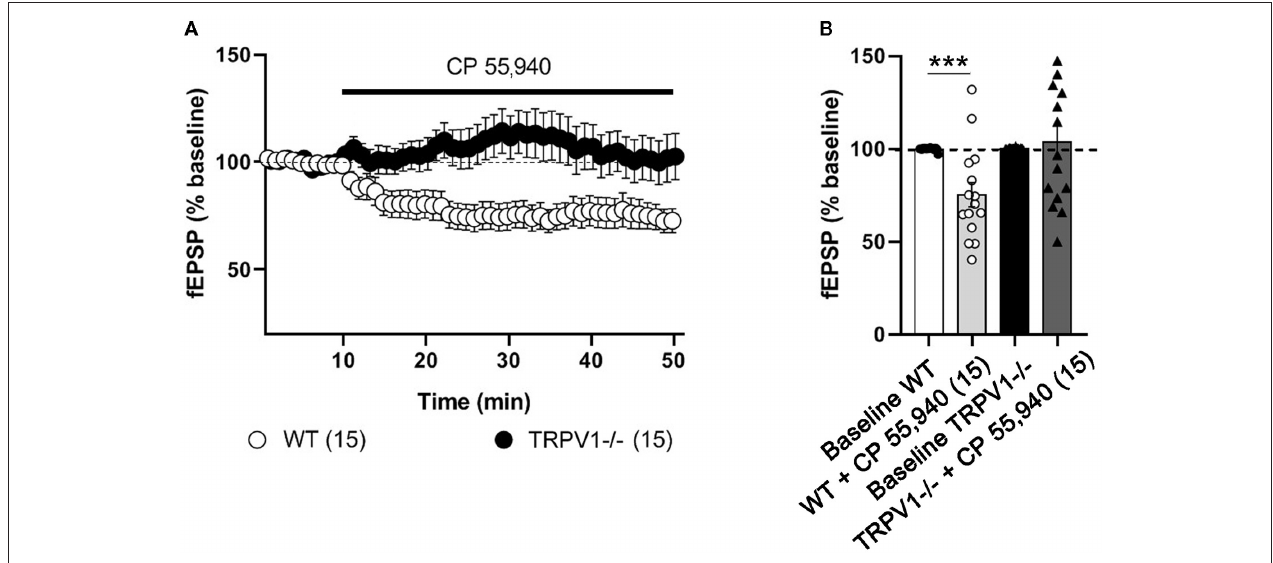
FIGURE 1 | Excitatory synaptic transmission at the medial perforant path (MPP) synapses in WT and TRPV1-/- mice. For representation, experiments were normalized to its baseline. (A) Time-course plot of average fEPSP areas is represented. Black arrow indicates the time point when the drug was applied. CP 55,940 [10 µ M] reduces significantly the excitatory synaptic transmission in WT, but not in TRPV1-/-. (B) Representative histograms of the last 10min of fEPSP after CP 55,940 application in WT (Mann–Whitney test. *** p < 0.001) and TRPV1-/- (Mann–Whitney test. p > 0.05) mice. All data are expressed as mean ±